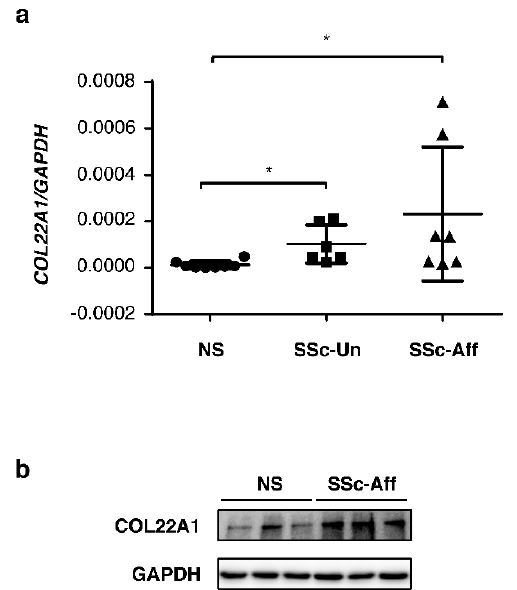
Figure 5. Increased expression levels of COL22A1 in SSc skin fibroblasts. Skin fibroblasts from healthy donors and patients with SSc were cultured in serum-free DMEM for 48 and 72 h. ( a ) Expression levels of COL22A1 mRNA were measured in the indicated group (HC; N = 8, SSc-Un; N= 6, SSc-Aff; N = 7); * p < 0.05. ( b ) Protein levels of COL22A1 were detected in normal skin fibroblasts and SSc skin fibroblasts using immunoblotting. GAPDH is shown as a loading control. NS = normal skin fibroblasts; SSc-Un = SSc-unaffected skin fibroblasts; SSc-Aff = SSc-affected skin fibroblasts.